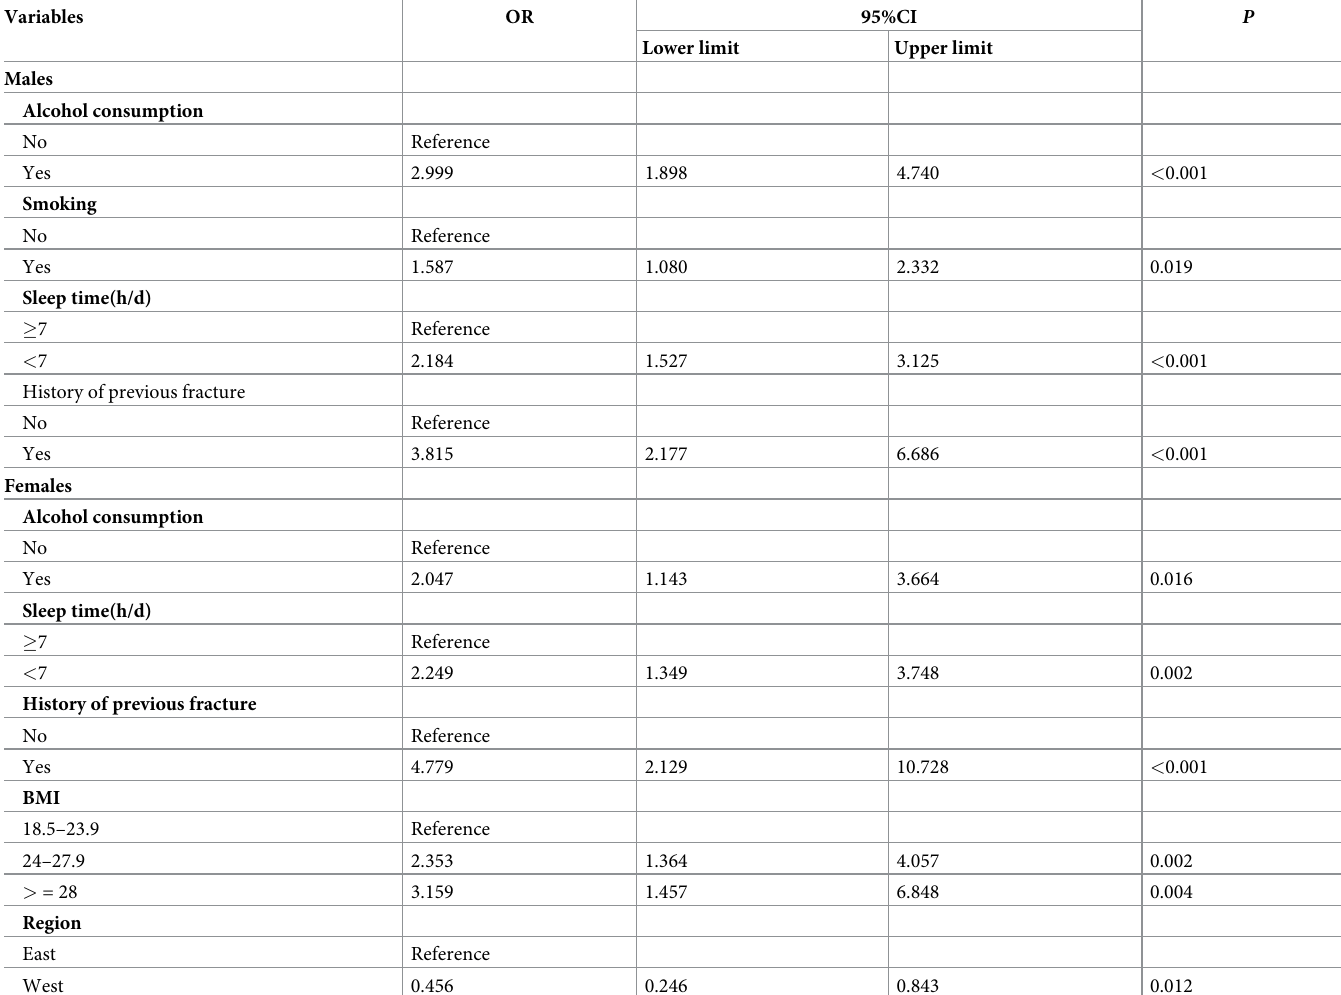
Table 5. Results of multivariate logistic regression of risk factors for foot